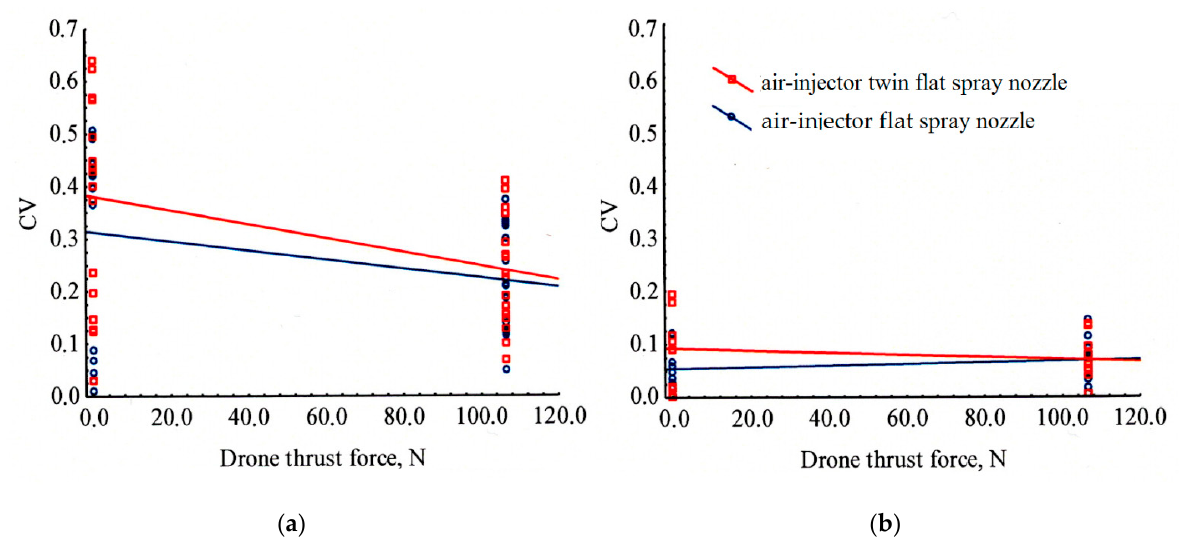
Figure 7. Impact of the drone thrust on the uniformity of the liquid stream distribution at the levels with the samplers placed: ( a ) In the tree crown; ( b ) Without the tree crown (drone thrust 106.7 N—drone rotors rotation 6000 rpm).